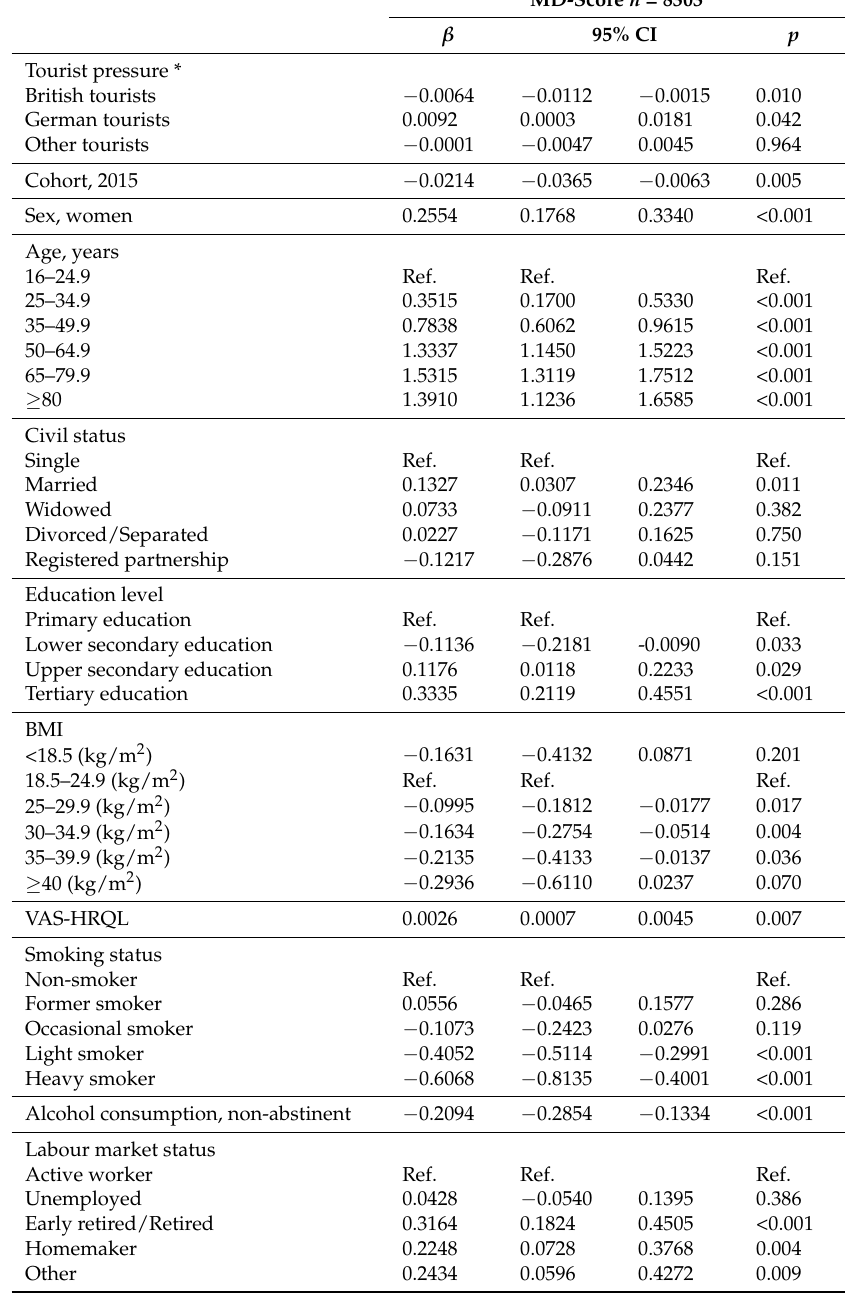
Table 3. Association between Mediterranean diet score (MD-score) and tourist pressure by nationality and characteristics of